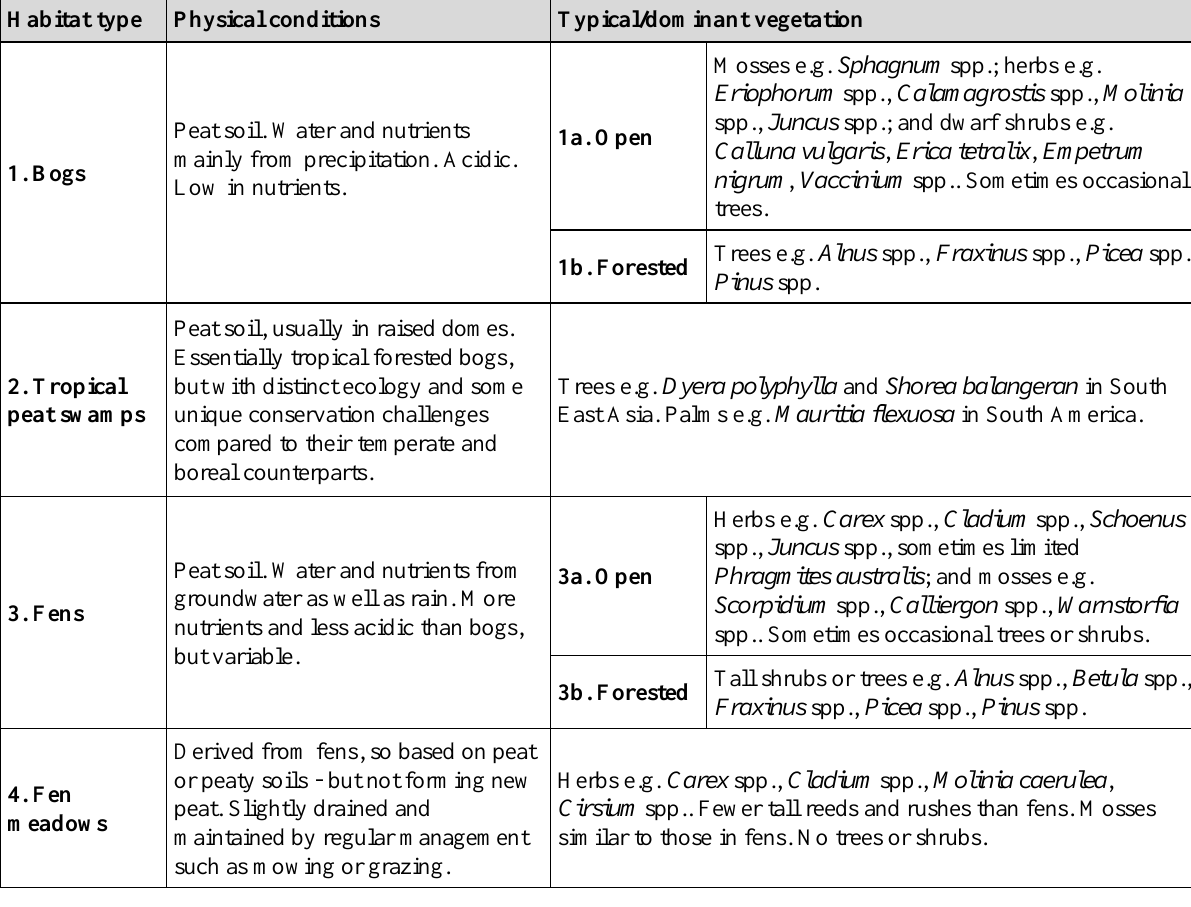
Table 1. Description of the six main habitat types covered in the Peatland Evidence Synthesis, adapted from Taylor et al. (2018a). Habitat types are based on ecological similarity, geographical similarity and existing fields of study. They are not